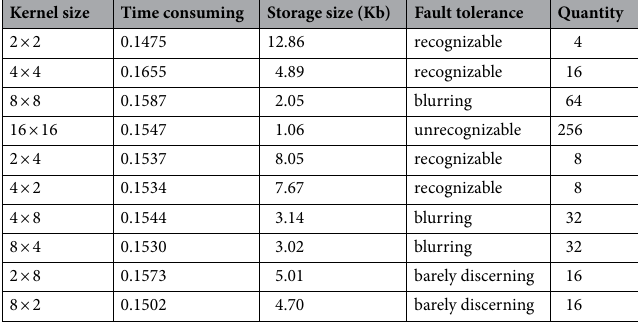
Table 1. Comparison of DP effects under different pooling kernel